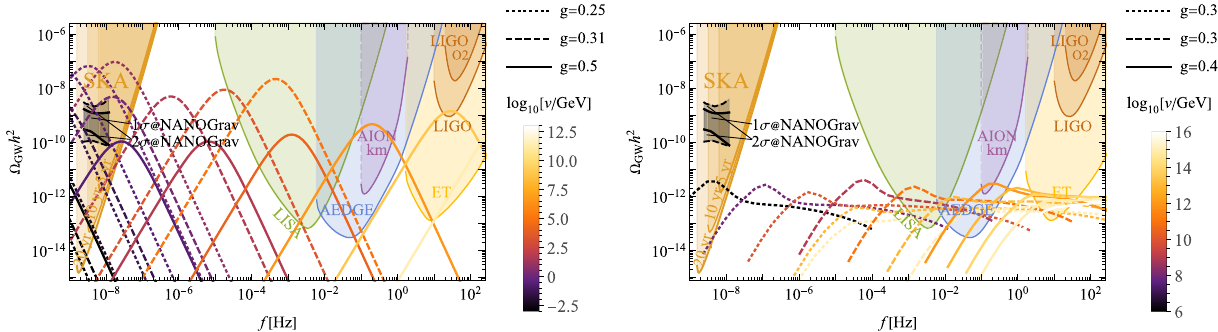
Fig. 5 Examples of GW spectra sourced by a bubble collisions (left panel) and the scalar field fluctuations (right panel) together with sensitivities of current and future GW detectors